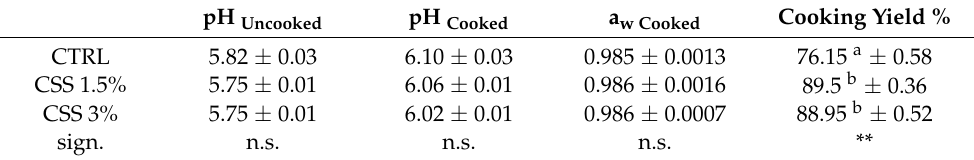
Table 2. Results (mean ± SD) of pH, water activity (a w ) values and cooking yield (%) in burger samples (CTRL, control; CSS 1.5% and CSS 3.0%, with +1.5% and +3.0% of coffee silver skin as ingredient,